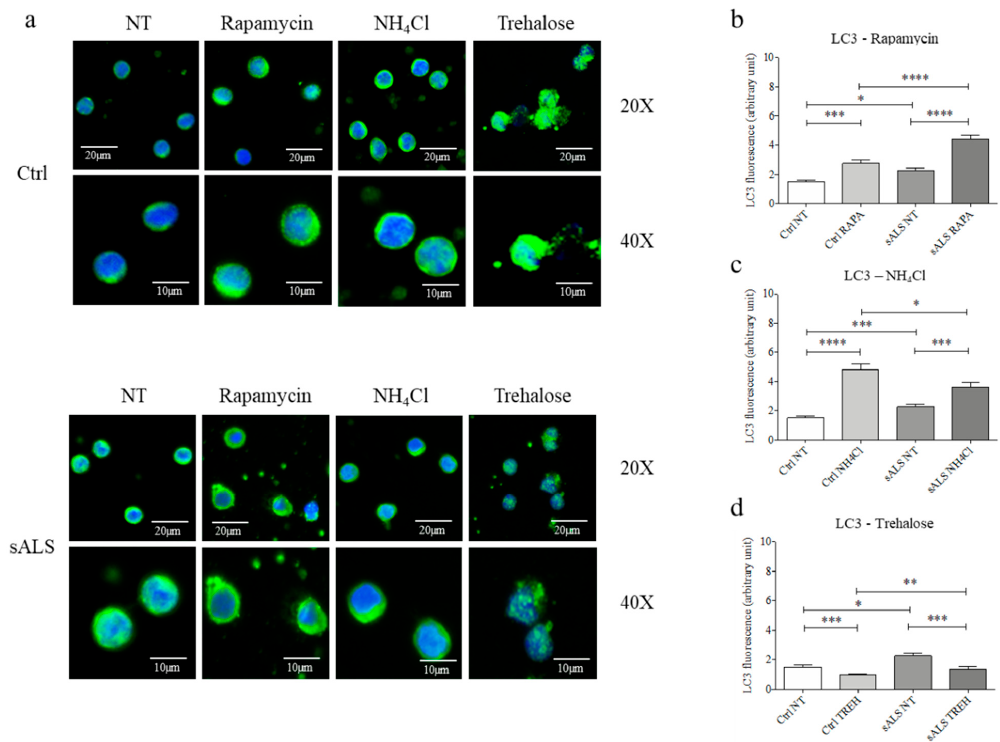
Figure 4. Dissection of autolysosomes generation sALS PBMCs vs. Controls. ( a ) Immunofluorescence analysis with LC3 revealed an accumulation of autophagosomes in sALS patients’ PBMCs in NT conditions. After rapamycin treatment we found an increased accumulation of LC3 in sALS PBMCs compared to controls. On the other hand, we found a higher increase in LC3 after NH4Cl treatment in healthy controls respect to sALS patients. Scale bar 20X: 20 µ m, Scale bar 40X: 10 µ m. N = 3 ( b ) ImageJ analysis of LC3 after rapamycin treatment. We found statistically significant differences between